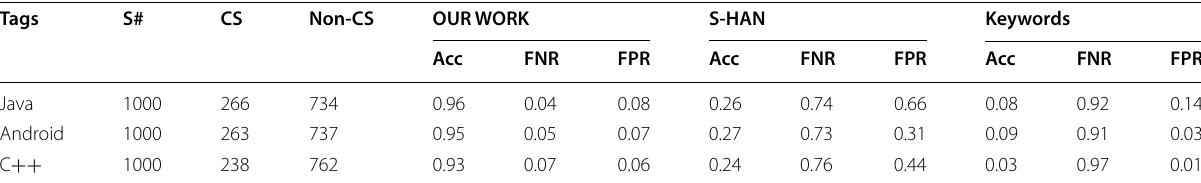
Table 3 Accuracy of CS extractor